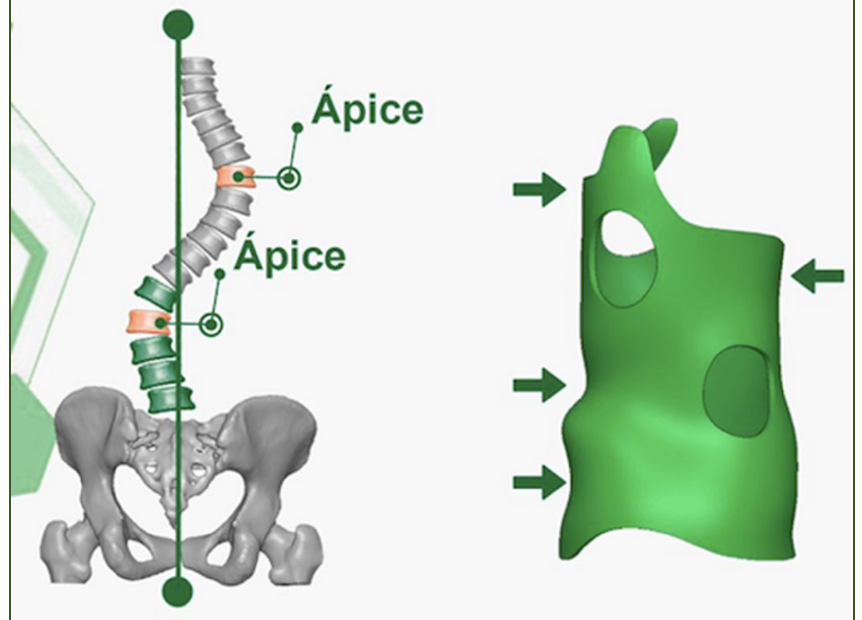
Figure 2. The spinal brace (S4D) used during short- and long-term use as an intervention program for the treatment of AIS, the arrows demonstrate the support and correction points of the brace on the spine.